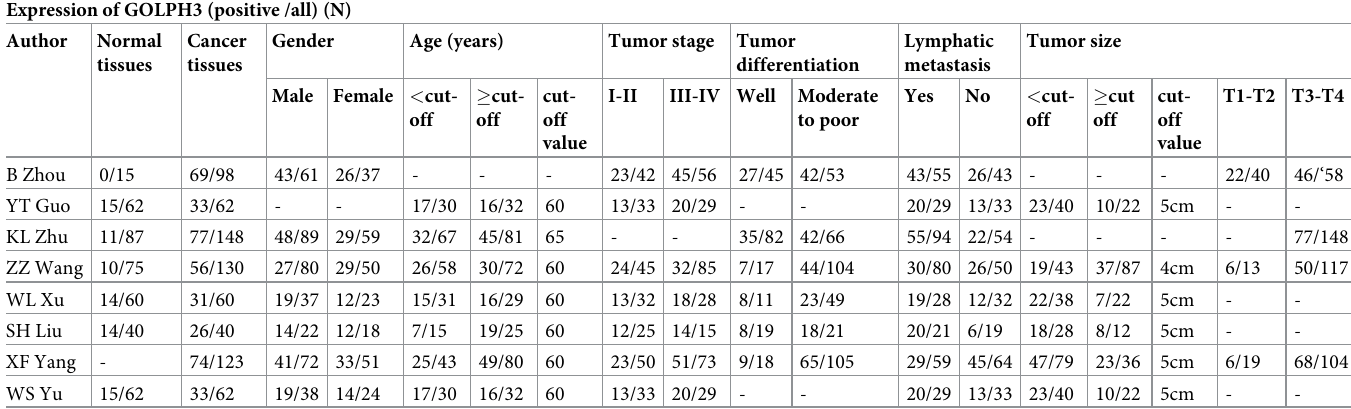
Table 2. The expression of GOLPH3 in cancer tissues and adjacent normal tissues and clinicopathological characteristics of patients with colorectal cancer. Expression of GOLPH3 (positive /all) (N)